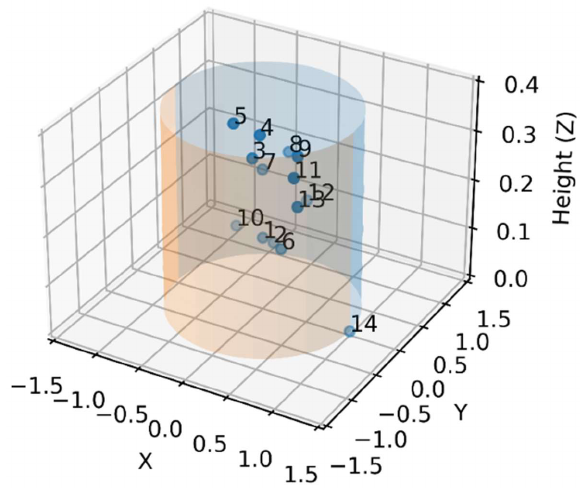
Figure 14. Position of the calculated bubbles using the PPM developed in this study. Calculation 2 at 60 SCFM. Table 5. Identification number for each bubble reported in Figure 14, along with size and velocity of each bubble. Bubble